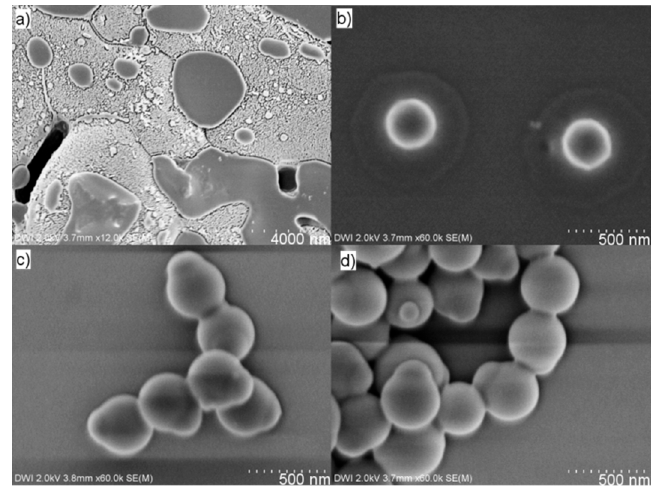
Figure 2. SEM images of reaction samples obtained after ( a ) 1 min, ( b ) 5 min, ( c ) 10 min, and ( d ) 120 min reaction time. Table 1. Patch diameters a at various times during the reaction, obtained through SEM analysis. Time